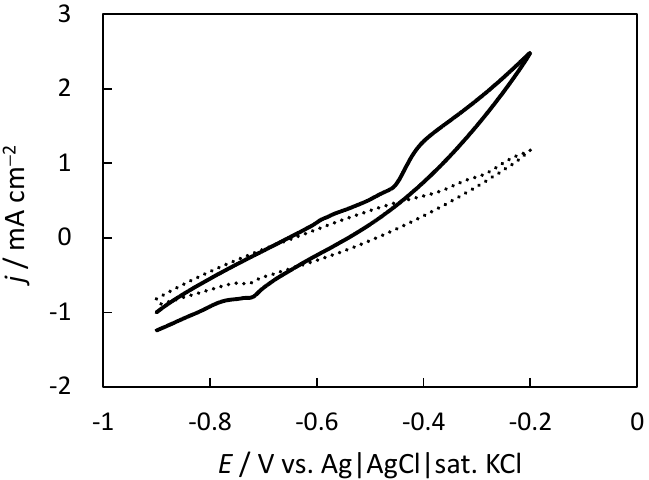
Figure 2. Cyclic voltammograms at the CFE in the indigo-dye fermenting suspension. The scan rate was 20 mV s − 1 . Measurements were conducted at room temperature (ca. 25 °C) (solid line) and 0 °C (dotted line) under quiescent and atmospheric conditions.